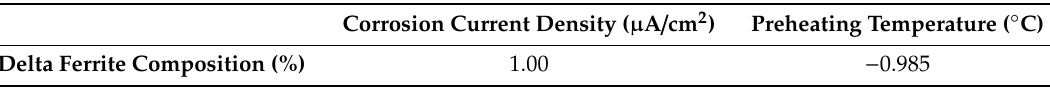
Table 10. Pearson correlation coe ffi cient between delta ferrite composition, corrosion current density and preheating